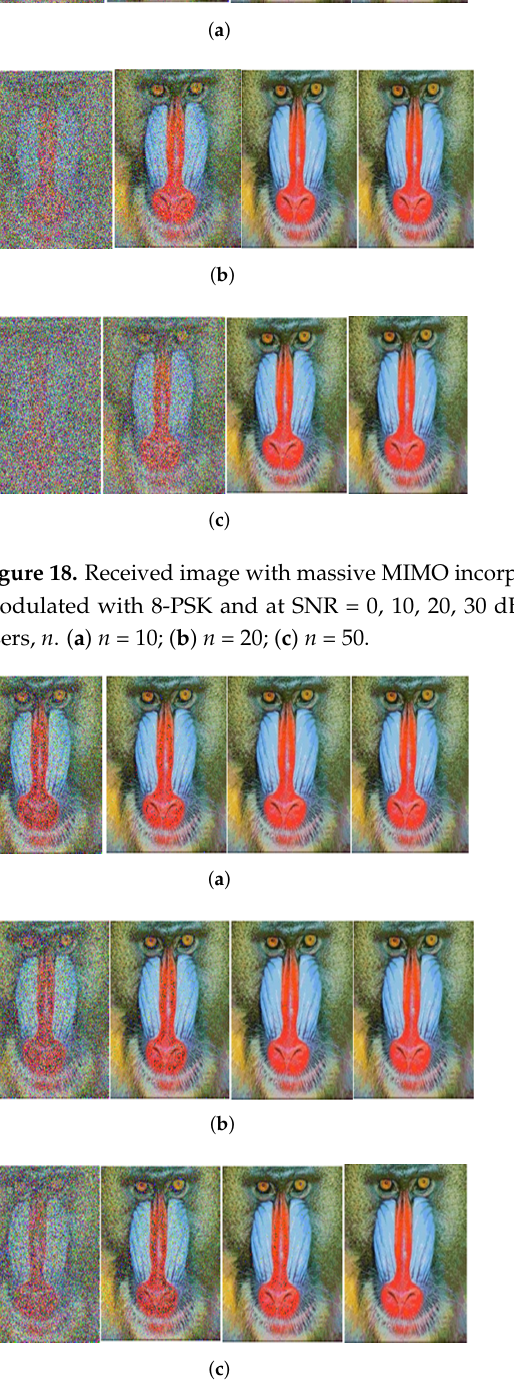
Figure 19. Received image with massive MIMO incorporated DWT-OFDM over a Rayleigh channel, Modulated with 16-PSK and at SNR = 0, 10, 20, 30 dB from Left to Right for different number of users, n . ( a ) n = 10; ( b ) n = 20; ( c ) n =